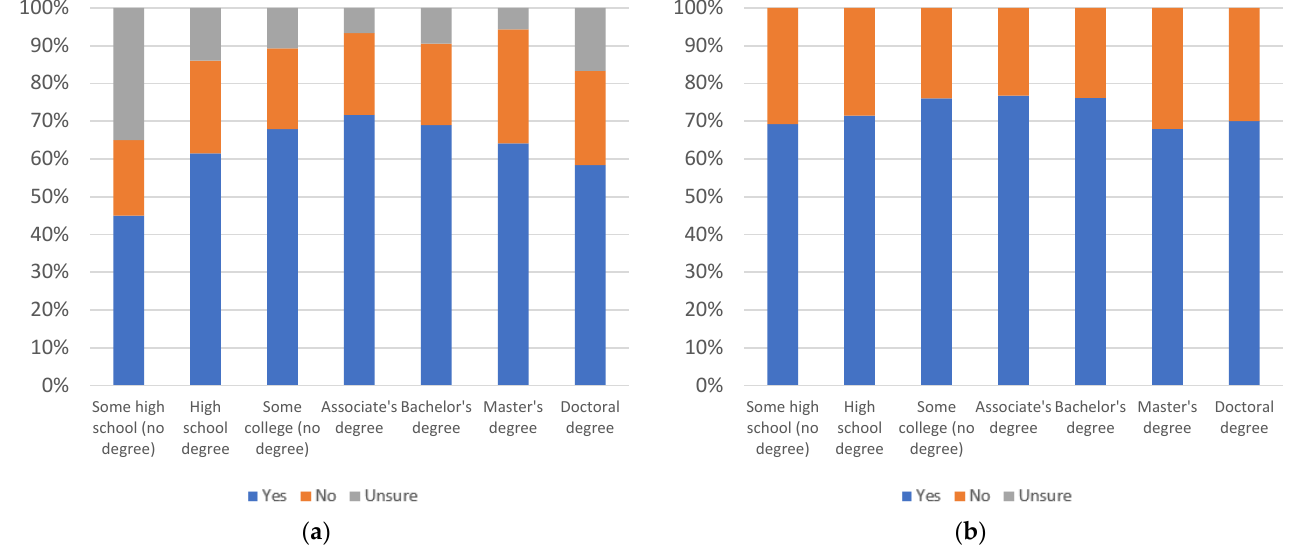
Figure 60. Label use, by education level: ( a ) with uncertain respondents (left) and ( b ) without uncertain respondents (right).